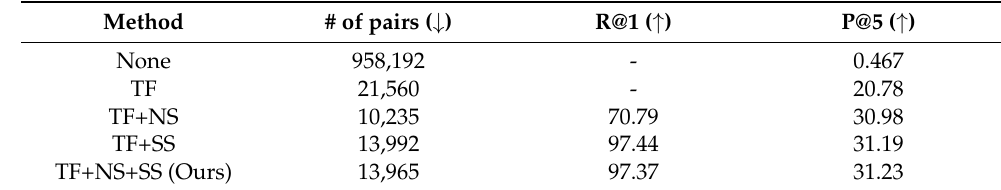
Table 3. Results for tracklet pair proposal using different methods on VidOR validation set. (The average number of tracklets in a video = 986).